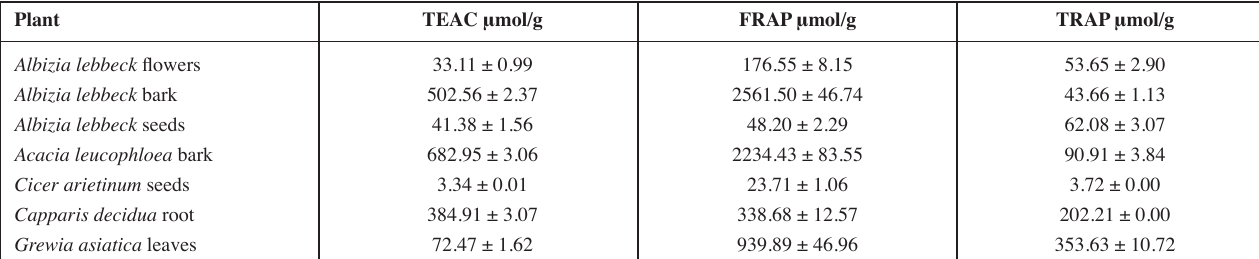
Tab. 4: TEAC, FRAP and TRAP values of plant extract analysed . Data are expressed as the mean ± standard deviation (n =3).